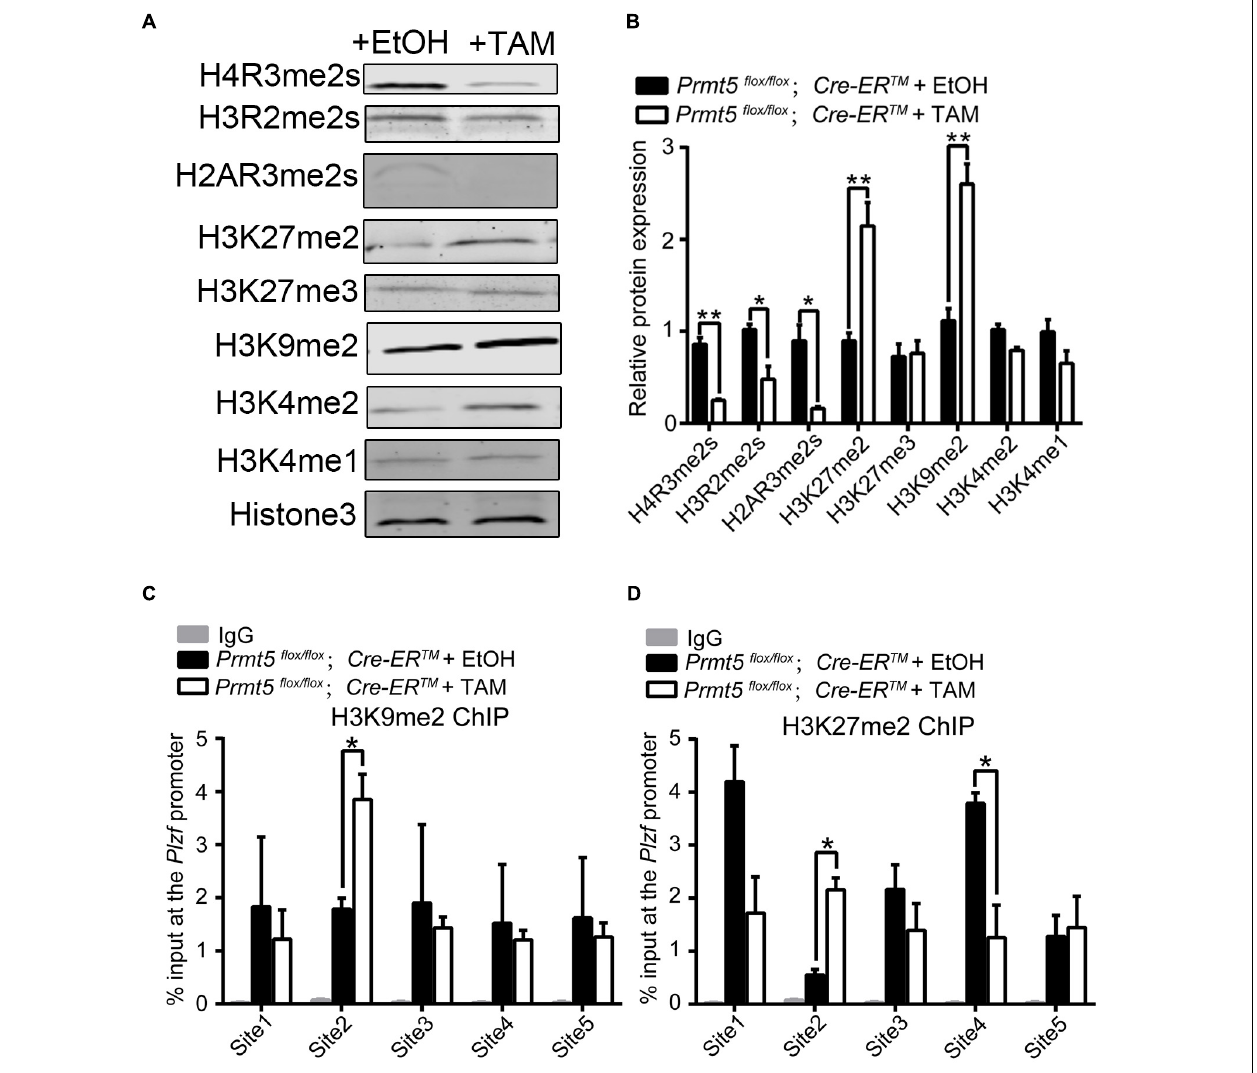
FIGURE 6 | H3K9me2 and H3K27me2 levels are significantly increased in Prmt5- deficient spermatogonial stem cells. (A) The level of histone modification in control and Prmt5 -deficient spermatogonial stem cells was examined by western blot. (B) Quantitative results of western blot analysis. ChIP assays were performed to analyze the enrichment of H3K27me2 (C) and H3K9me2 (D) modifications in the promoter regions (TSS-1 kb upstream of TSS) of the Plzf (site 1 ∼ site 5) gene in control and Prmt5 -deficient SSCs. The relative enrichment of the Plzf promoter region was examined by real-time PCR using sequence-specific primer sets. IgG was used as a negative control. Site 1: − 114 ∼− 284 bp, Site 2: − 175 ∼− 347 bp, Site 3: − 381 ∼− 552 bp, Site 4: − 573 ∼− 743 bp, Site 5: − 755 ∼− 948 bp. Quantitative data are presented as the enrichment of the ChIP to the input DNA. TSS, transcription start site. Error bars present SEM of three ChIP experiments. * P < 0.05, ** P < 0.005 indicates a significant difference ( t